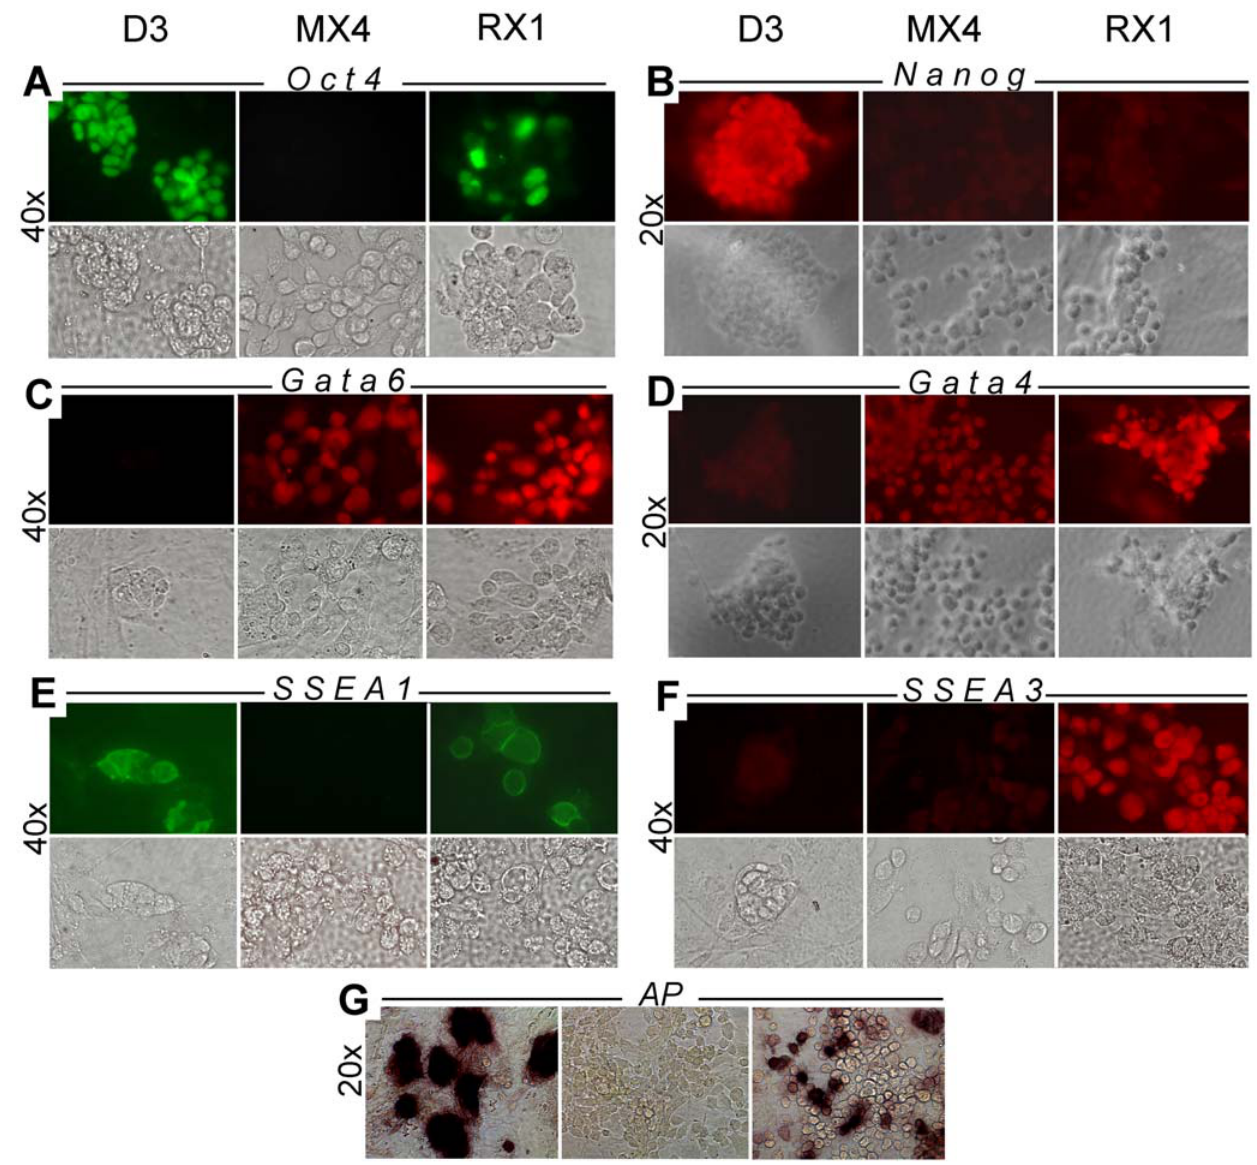
Figure 3. Heterogeneity of lineage marker expression in rat XEN-P cell lines. Rat XEN-P (line RX1), mouse XEN (line MX4), and mouse ES (line D3) cell lines were analyzed by indirect immunofluorescence with antibodies specifically recognizing Oct4 ( A ), Nanog ( B ), Gata6 ( C ), Gata4 ( D ), SSEA1 ( E ), or SSEA3 ( F ), or they were stained for alkaline phosphatase activity ( G ). Controls in which primary antibodies were omitted were negative and are not shown. Upper rows show immunofluorescence, lower rows show bright field images. Using immunocytochemistry, we also analyzed Oct4 and SSEA1 expression in line RX2 and SSEA1 expression in line RX5; the lines were positive, but the percentages of positive cells were lower than in line RX1 (results not